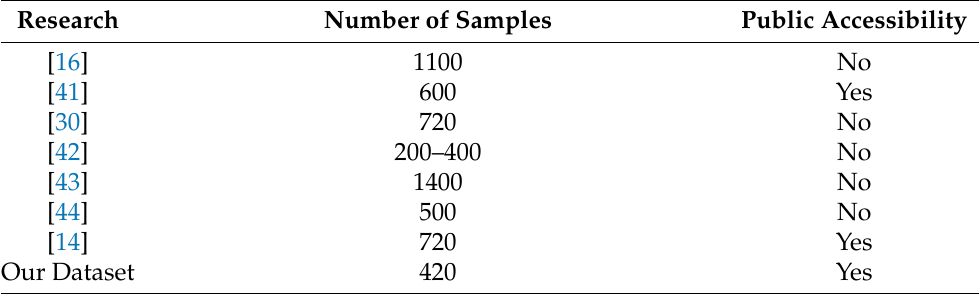
Table 2. Number of samples and data accessibility in different CSI-based HAR researches.